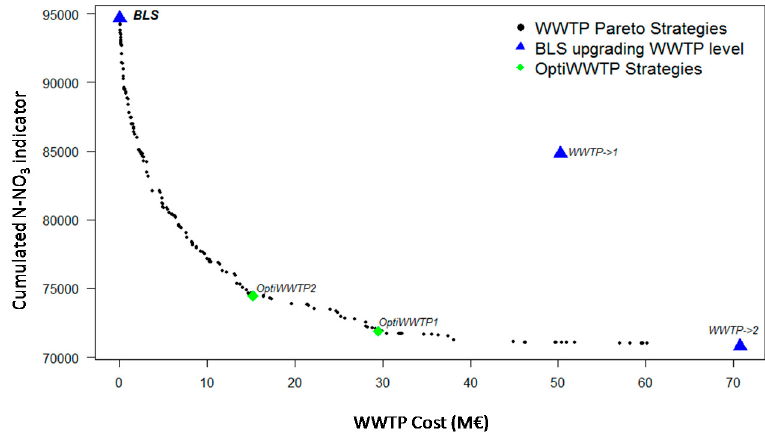
Figure 6. Pareto front of the WWTP optimal upgrade, considering the objectives of minimizing cost and minimizing N ‐ NO 3 concentration, confronted with the all WWTP upgrading strategies to level 1 or 2.